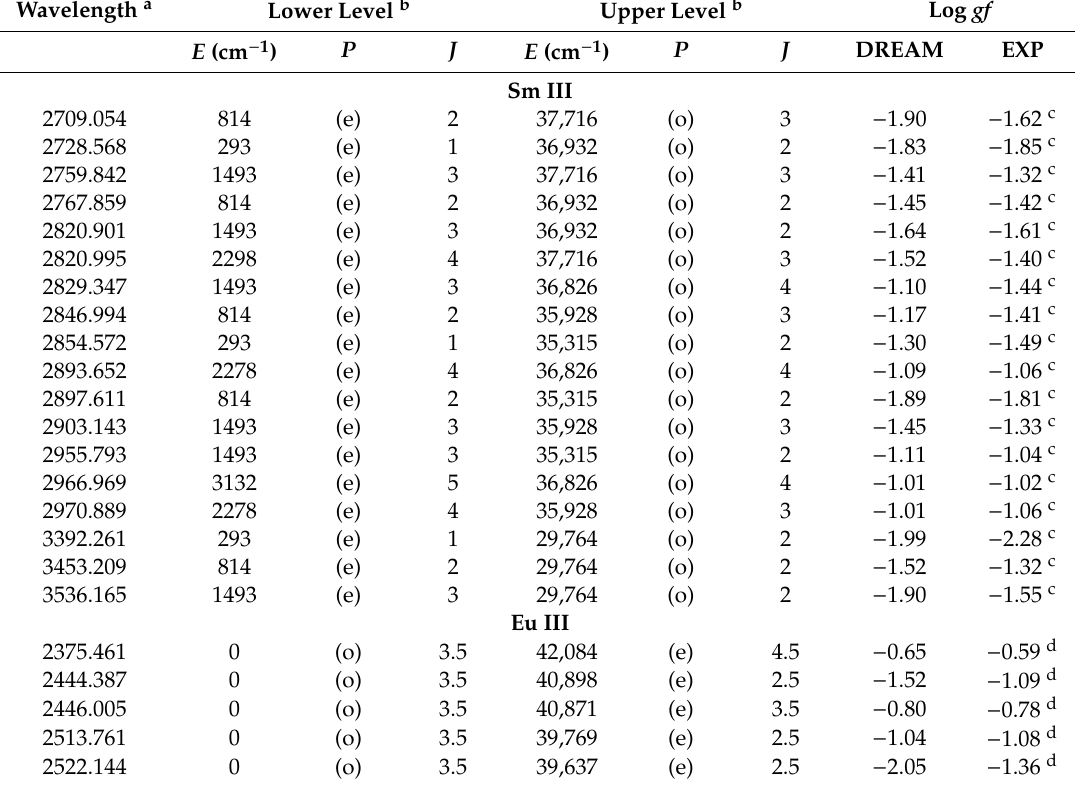
Table 2. Comparison between the oscillator strengths taken from DREAM and available experimental data for Sm III, Eu III, Tm III and Yb